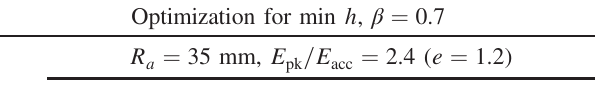
=E = 42 , and dimensions of TABLE V. Values of h ¼ H pk acc optimized inner cell (two elliptic arcs and a straight segment) vs =E the slope angle α . Optimization for min H (or min h ). pk acc Optimization for min h , β ¼ 0 . 7